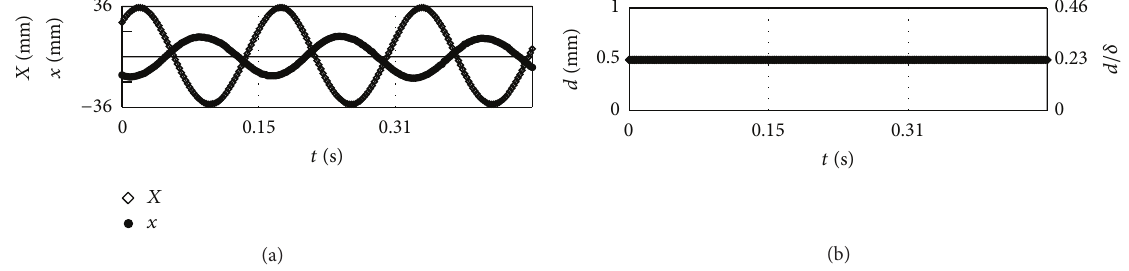
Figure 11: Characteristics of the body oscillations just after repulsion from the bottom, 𝑓 = 7.3 Hz.